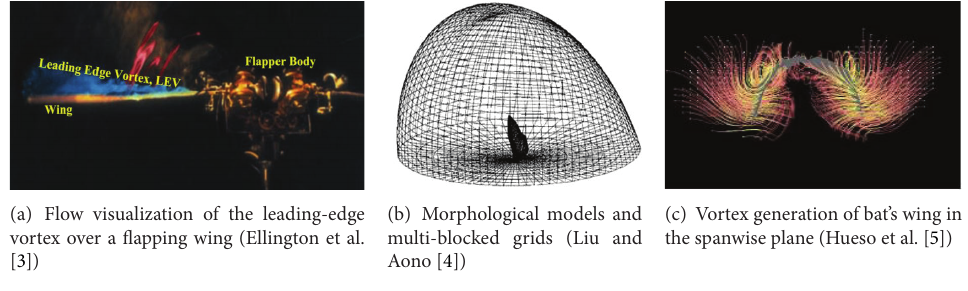
Figure 1: The presence of vortices in simulated airflow around the flapping wing